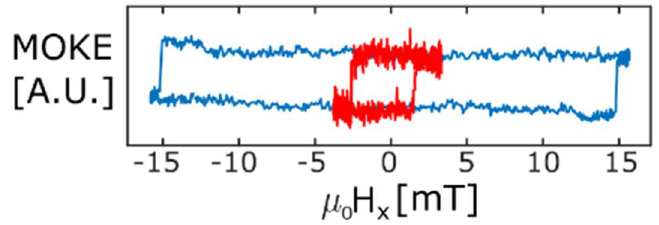
Figure 13. MOKE loops obtained for two rotating fields of different magnitude: 16 mT (blue) and 3.4 mT (red) displaying characteristic signatures of high-quality domain wall transport such as reduction in coercivity and emergence of asymmetries at small field magnitude.